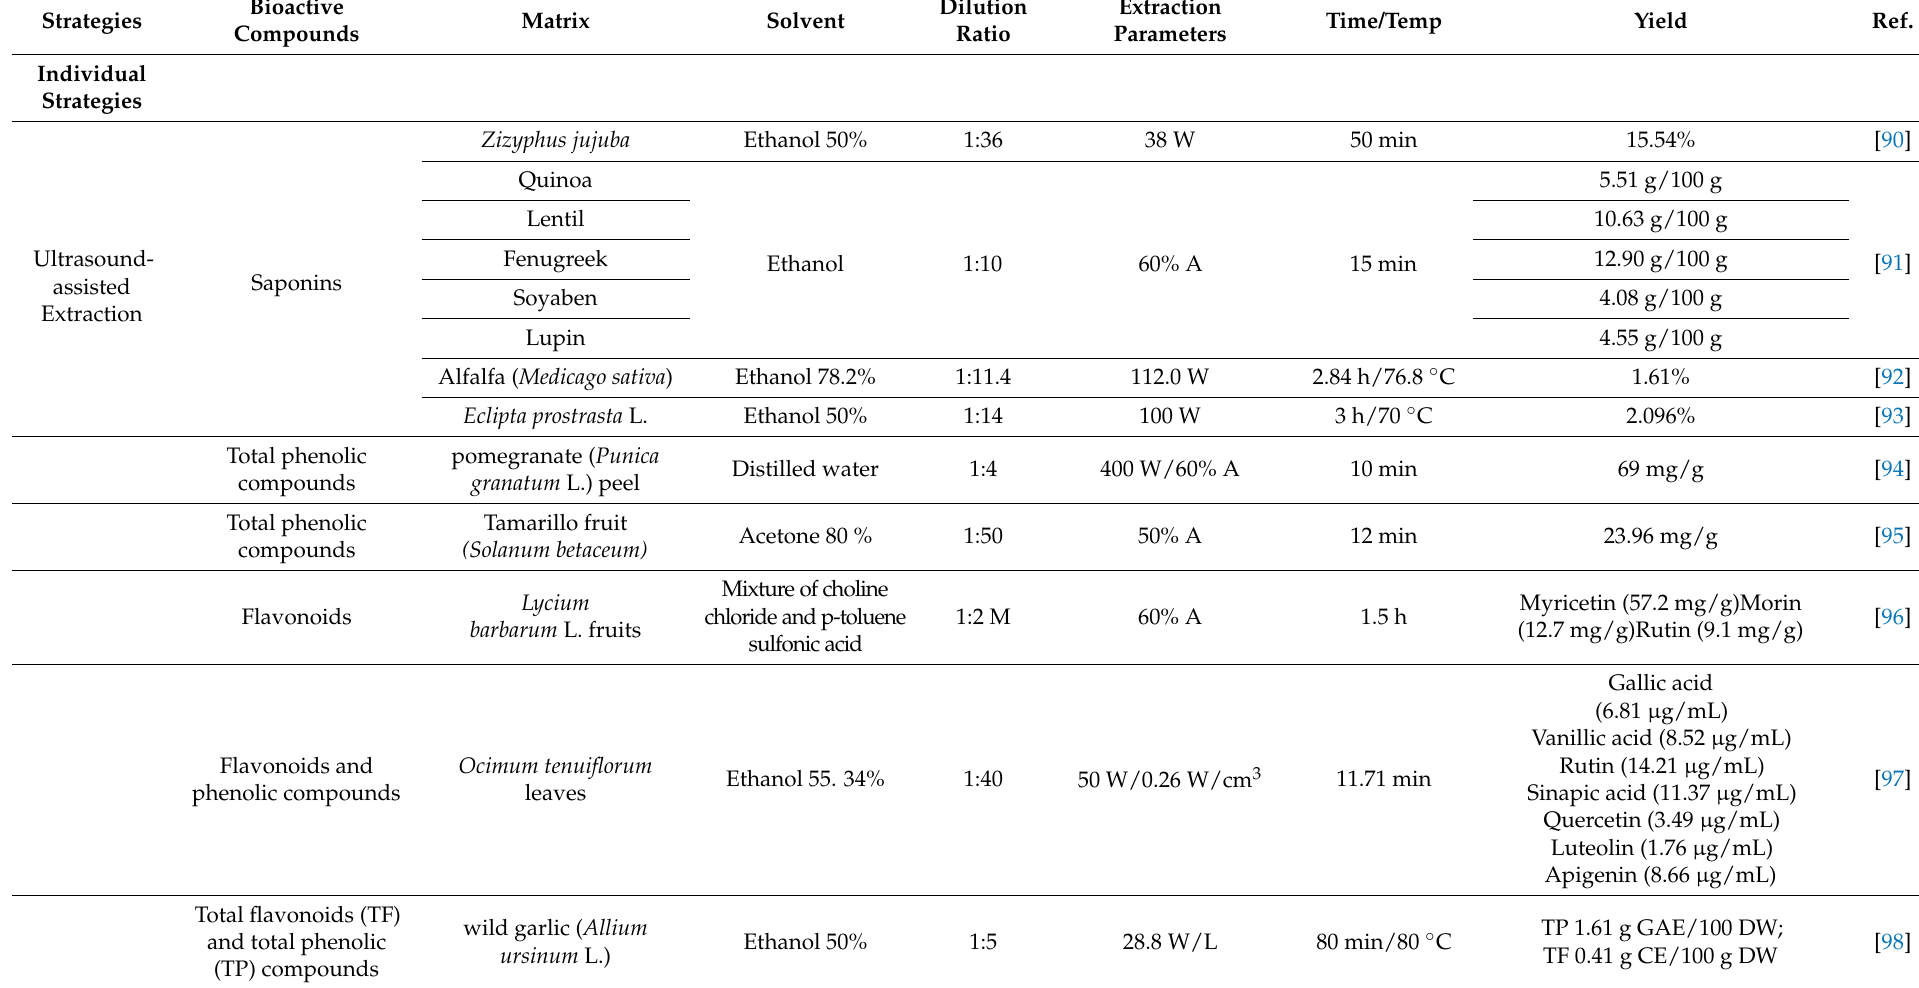
Table 1. Novel extraction strategies for the extraction of bioactive